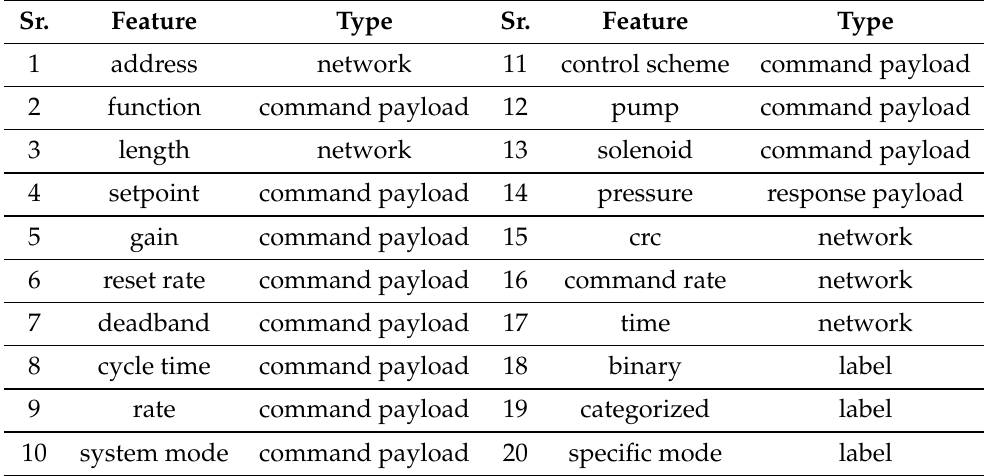
Table 1. A complete feature list of the network payload in the dataset.